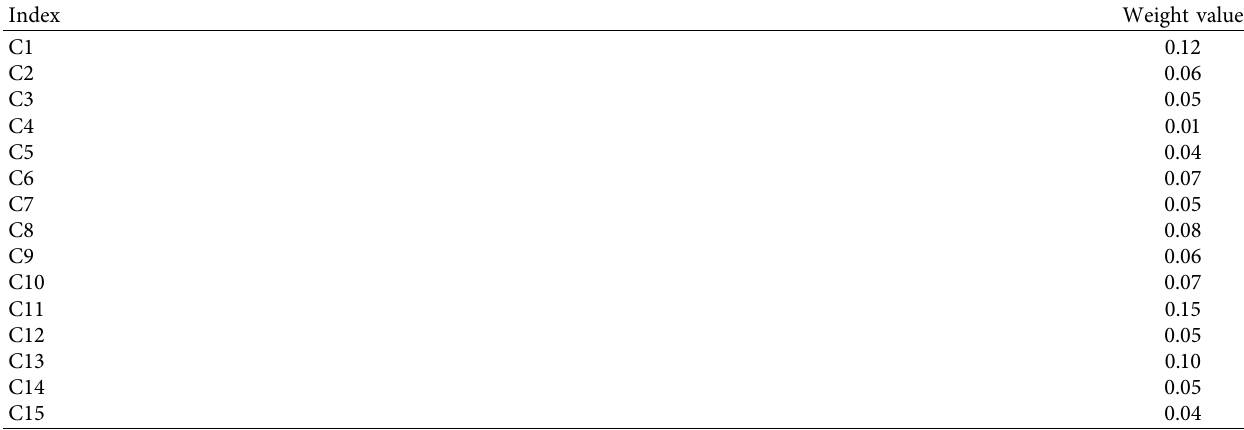
Table 3: Calculation results of the index weight.